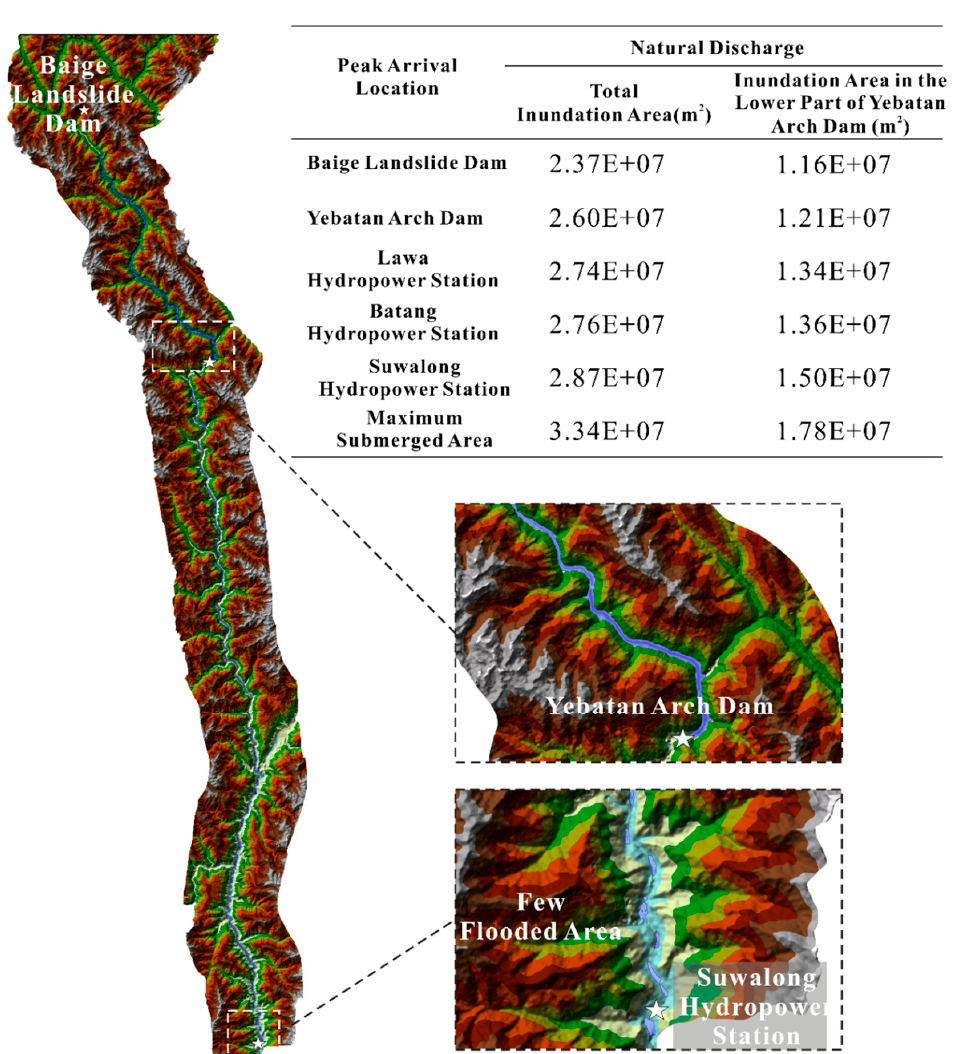
Figure 10. Outburst flood process at the Baige landslide dam and four downstream power stations with high dam interception.